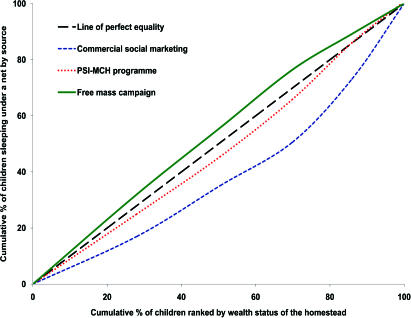
Degree of Inequality in Socioeconomic Targeting by the Three Principal Net Delivery Mechanisms in Four Districts in Kenya by 2006/7Delivery mechanisms included commercial social marketing, the PSI-MCH programme, and a free mass campaign.